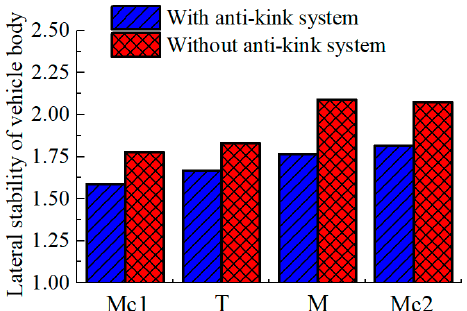
Figure 20. Lateral stability of vehicle body.